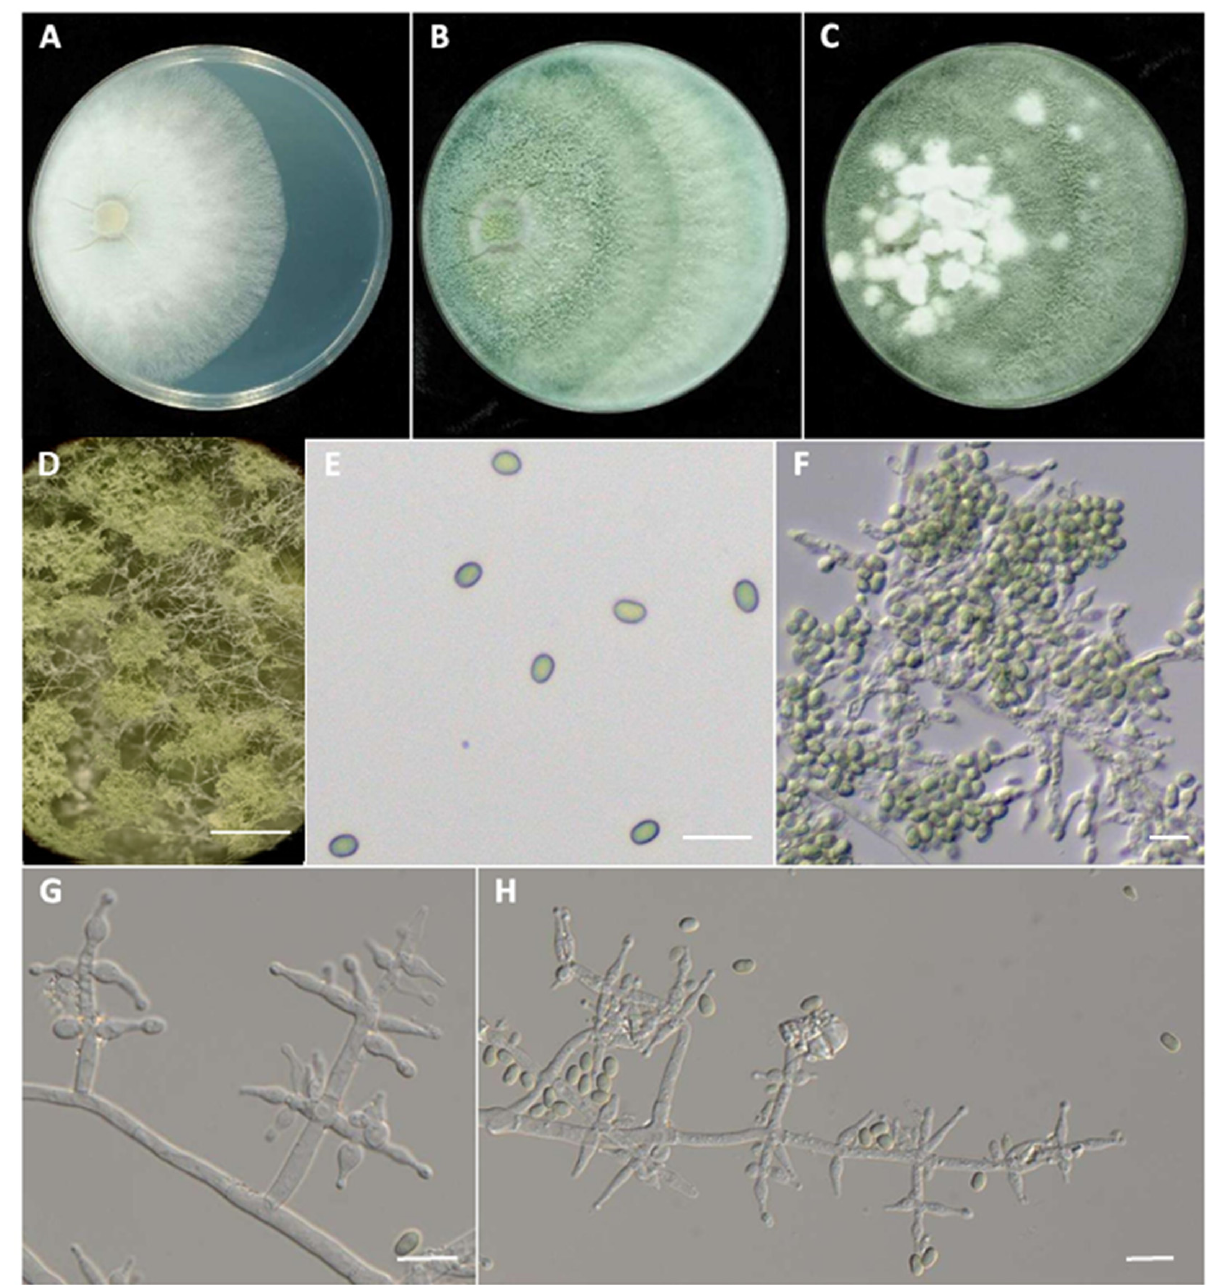
Figure 2. Trichoderma canadense SuRDC-1422. Cultures on PDA at ~22 °C after 3 d ( A ), 7 d ( B ), and 14 d ( C ). Conidiation pustules on PDA after 14 d ( D ). Single conidia ( E ) and mass conidia ( F ). Conidiophores and phialides ( G , H ). Scale bars represent 1 mm ( D ) and 10 µm ( E – H ). Mycobank#